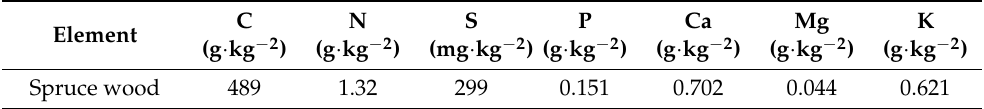
Table 1. Elementary analysis of spruce wood used for the